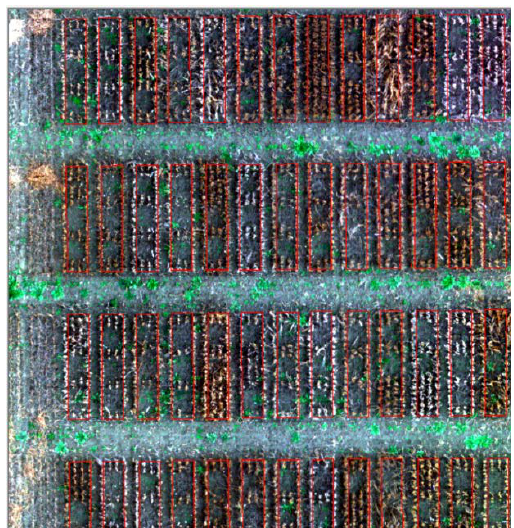
Figure 11: Altum Orthomosaic Overlaid with Plot Boundaries